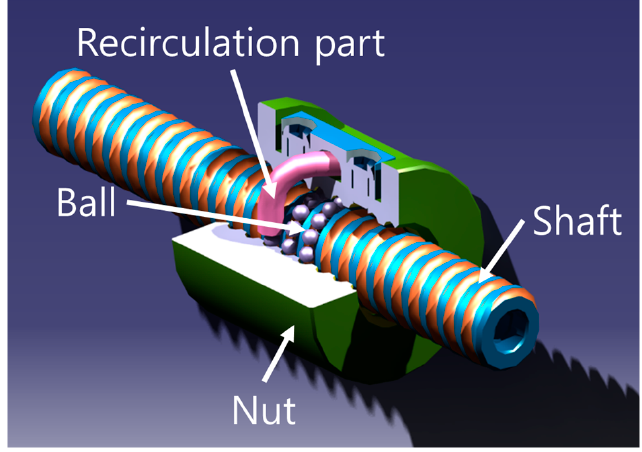
Figure 1. Ball screw configuration.